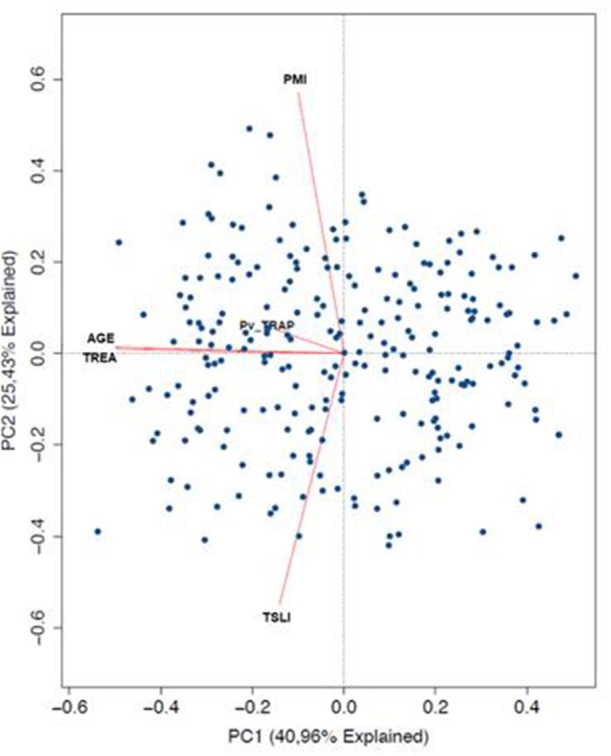
Principal Component analysis of IgG Anti-PvTRAP and epidemiological variables. Representation of principal components 1 (PC1 = 40.96% and 2 PC2 = 25.43%). Each point in the graphs represents a single individual along multidimensional space. The length of the arrows represents the strengh in variability explaining for each principal component. (TREA, time of residence in the endemic area; PMI, past malaria infections; TSLI, time since the last malaria infection/episode).